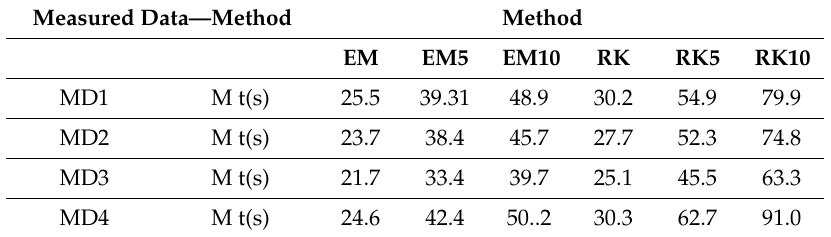
Figure 22. Measured and calculated responses in the case of MD4 using: ( a ) EM10; ( b ) RK10. Division of the time interval in the case of the motor simulations results in a higher number of calculations, and, with that, with a longer calculation time. Calculation times using E, EM5, EM10, RK, RK5, and RK10 for all measured input data are presented in Table 28. Table 28. Mean values of the calculation times for 50 independent runs using EM, EM5, EM10, RK, RK5, and RK10 for all measured input data.